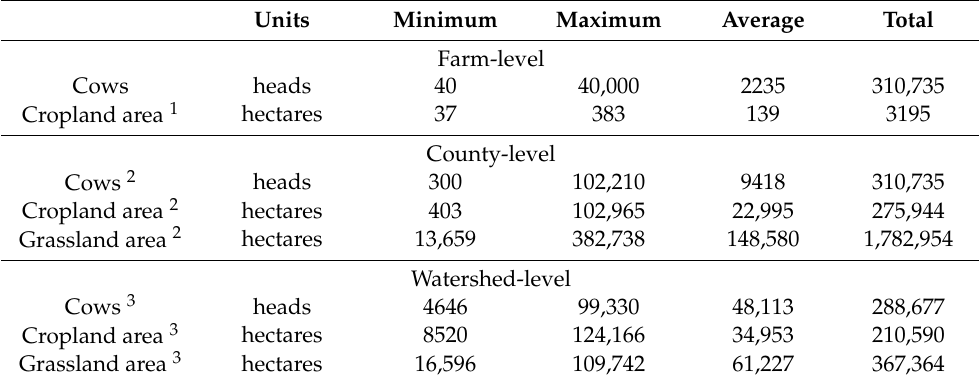
Table 1. Summary statistics of dairy farms, croplands, and grasslands in New